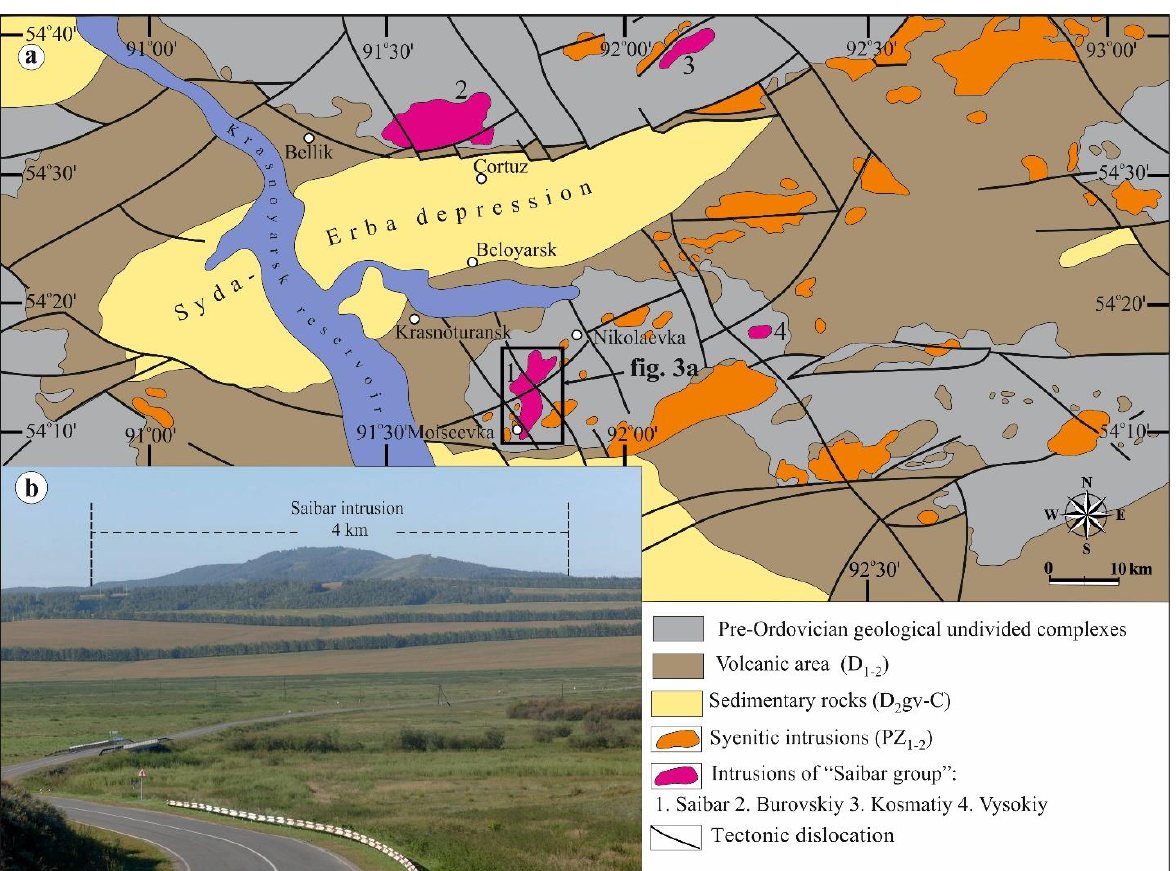
Figure 2. ( а ) Location of syenite-granite intrusions in the Syda-Erba depression of the Minusinsk Trough, modified from [49]. ( b ) Representative photos showing survey panorama of the Saibar intrusion; the distance to the peak of the intrusion is about 10 km (view from the side of the Nikolaevka village).